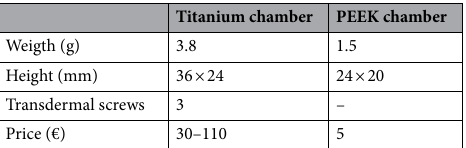
Table 1. Comparison of the titanium and PEEK chamber.